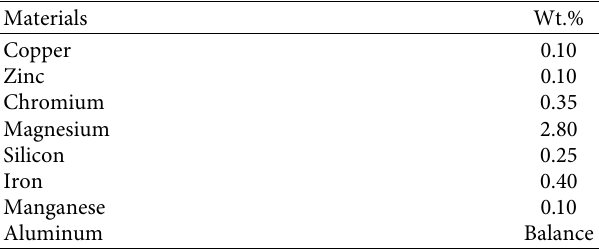
Table 1: Chemical arrangement of the AA 5052.